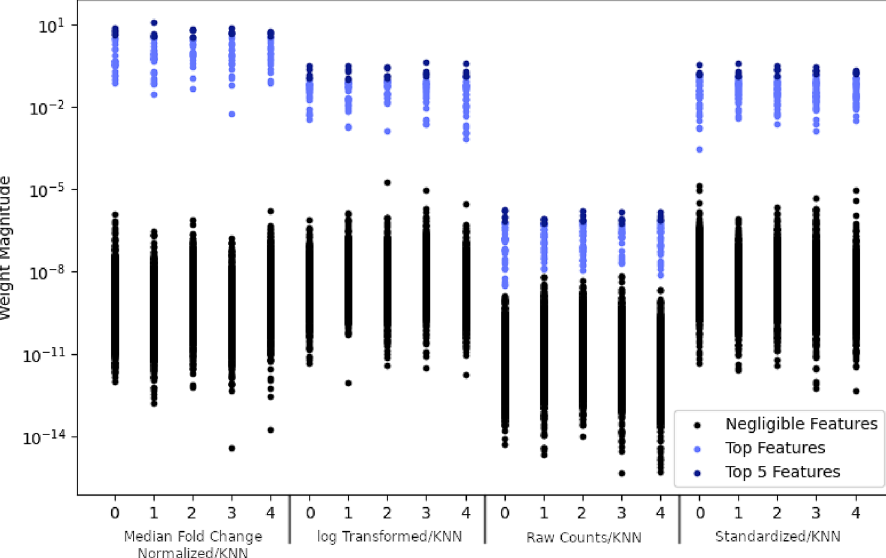
Figure 2. Magnitude of weights in SSVM model used in k FFS on training samples. The labels at the bottom indicate the transformation/imputation scheme used on the data, while the numeric ticks indicate the fold in k FFS.